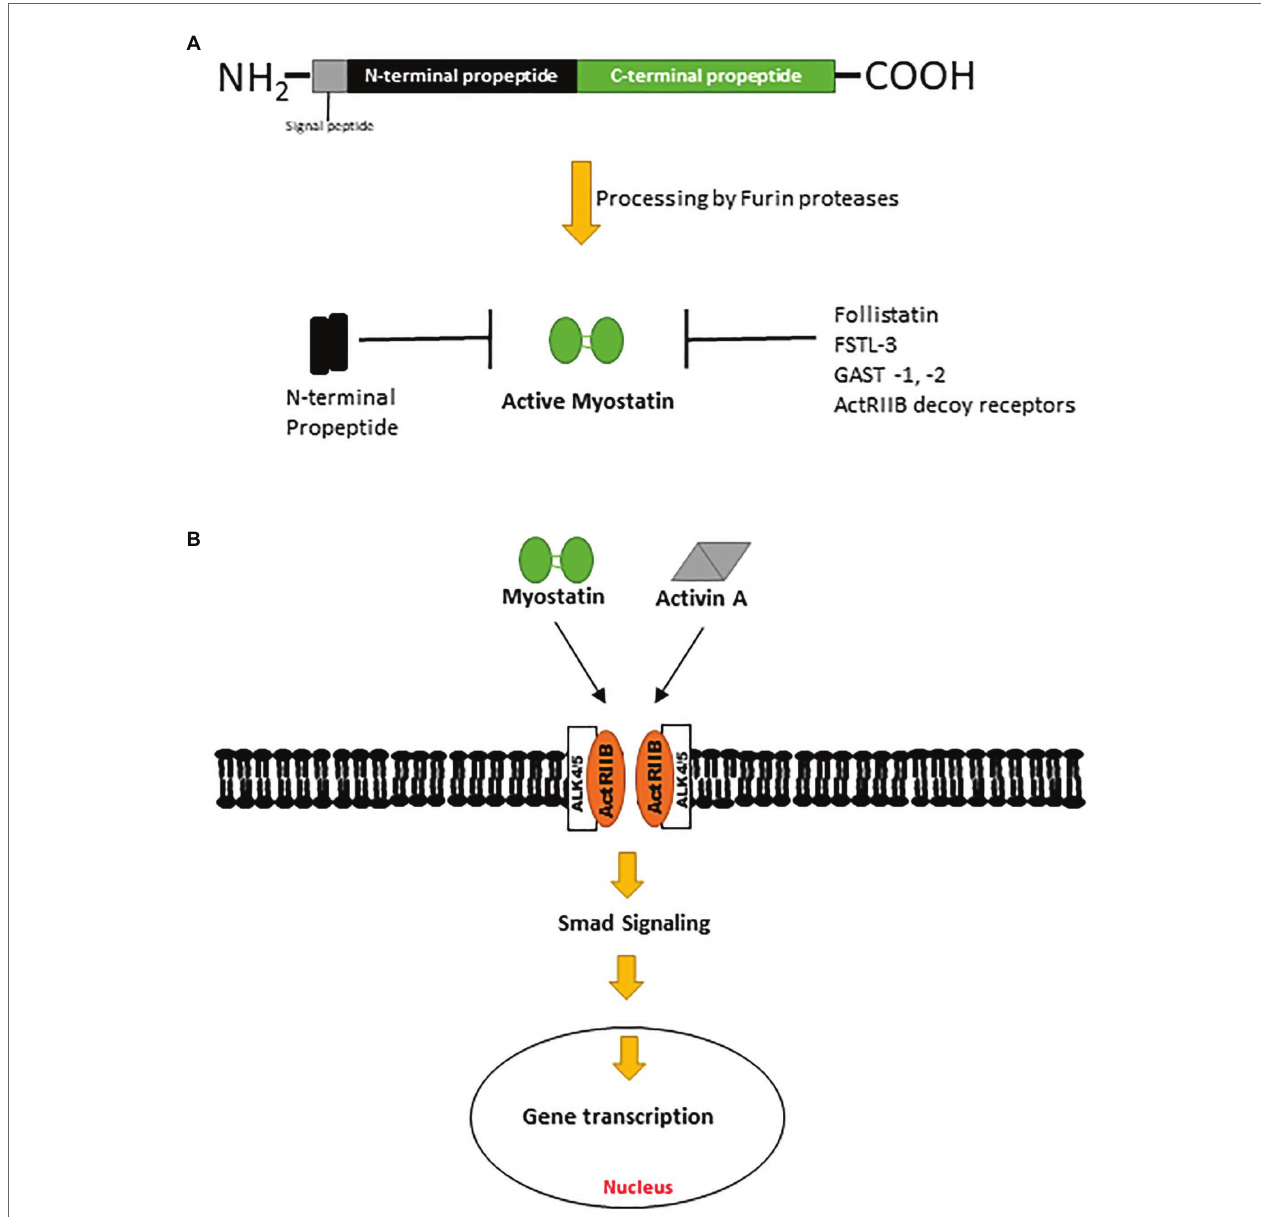
FIGURE 1 | (A) Pre-promyostatin is synthesized as a 375 amino acid peptide with a signal peptide domain and N‐ and C-terminal domains. Cleavage by furin proteases generate an active myostatin C-terminal dimer which can then form non-covalent complexes with the N-terminal fragments, becoming latent. (B)